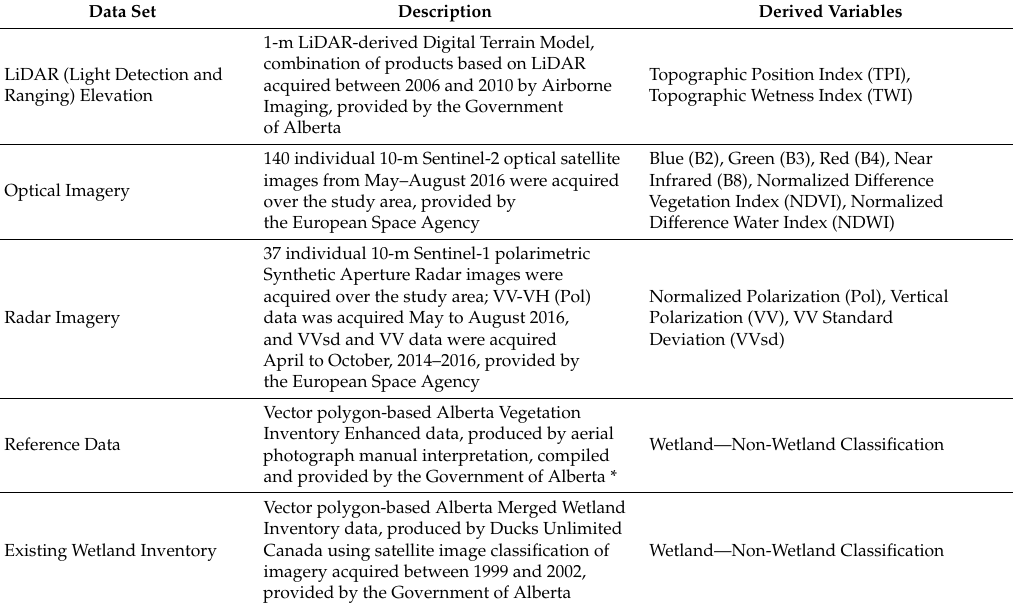
Table 1. List and description of data sets included in the study, along with variables derived from each